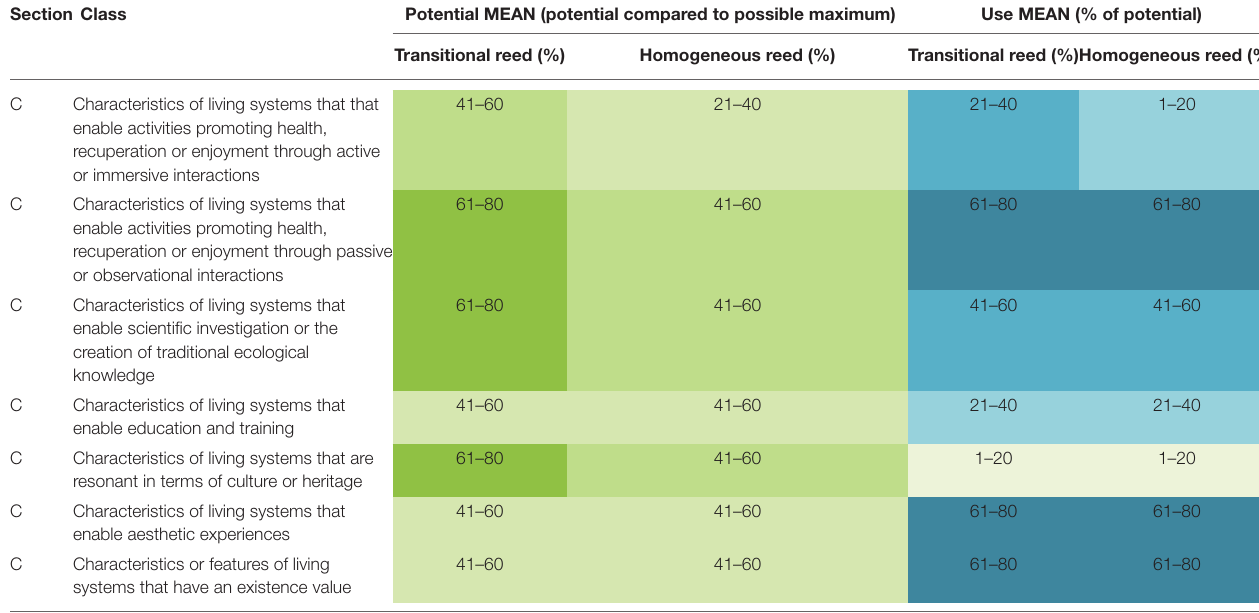
TABLE 3 | Results of the authors’ ecosystem service assessment for cultural services in transitional and homogeneous reed